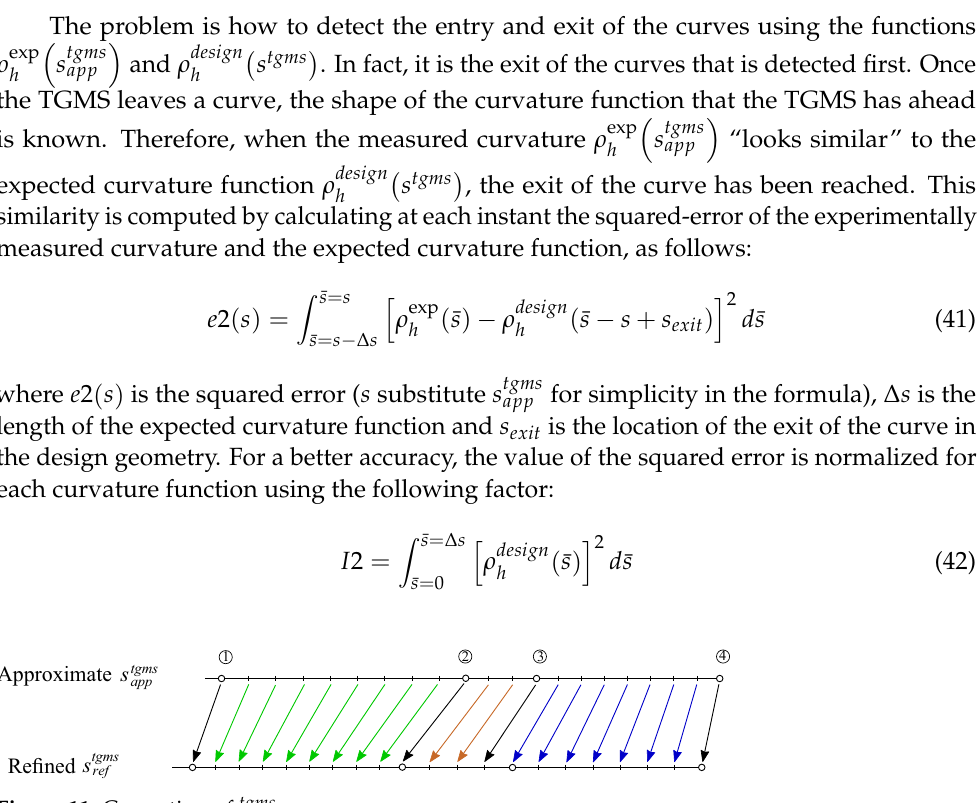
Figure 11. Correction of tgms